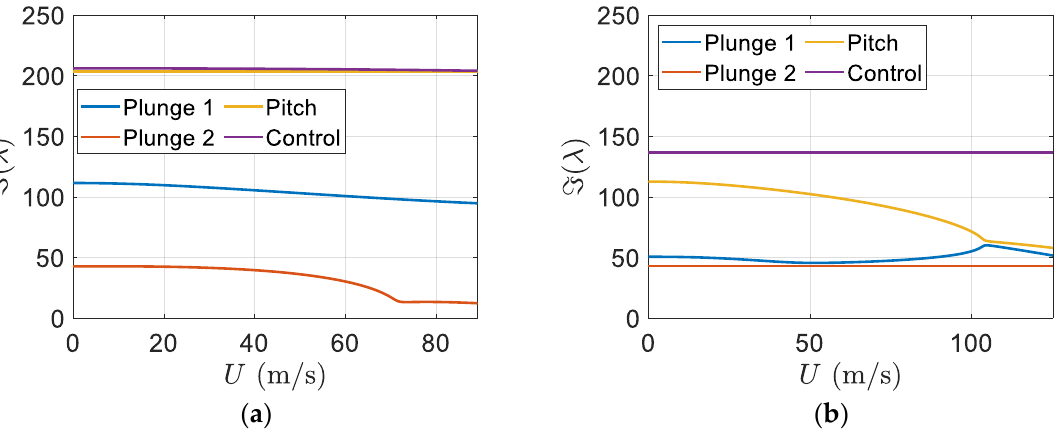
Figure 18. Eigenvalues imaginary part versus airspeed: ( a ) smart blade with plunge piezopatches; ( b ) smart blade with plunge and pitch piezopatches.